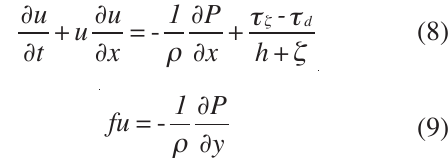
F IG . 4. – Results of the cross spectral analysis between C (t) vs u (t) (dashed line), horizontal line means for 95% significant level for coherence in accordance with Box and Jenkins (solid line) and S l l (1970); b) percentage of variance explained for each frequency band - C estimations have been made with 9 degrees of freedom and a band width of ∆ω =0.0432